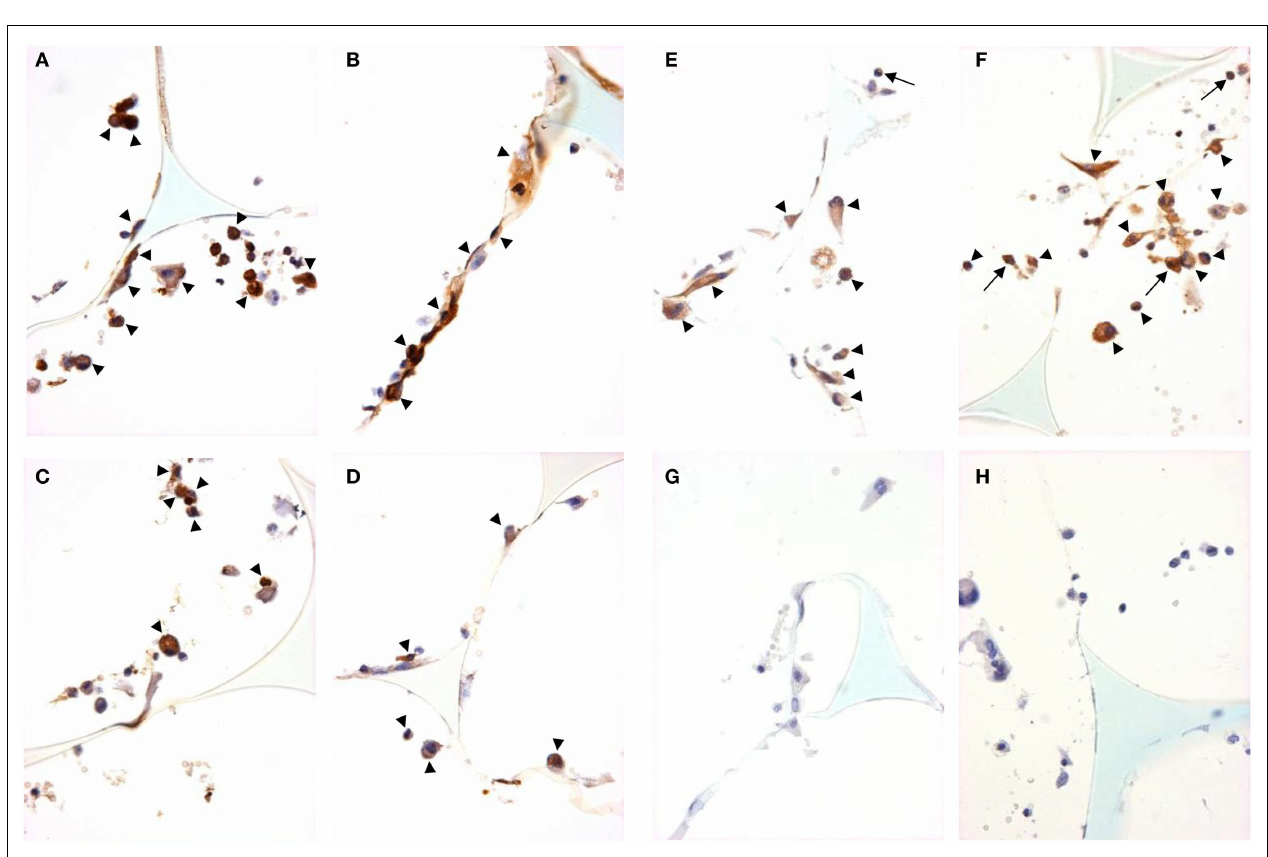
brown (DAB), nuclei blue-purple (hematoxylin), and sponge spicules light blue. Sections from either mouse strain contained cells with positive cytoplasmic staining (arrowheads), but some cells did not contain detectible levels of arginase-1,Ym-1, or phospho-STAT-6. Some cells were observed with nuclear phospho-STAT-6 staining (arrows) (Magnification: ×